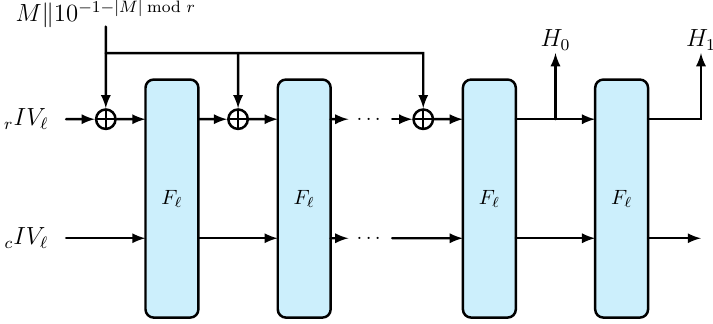
Figure 7: The structure of SKINNY-Hash based on a